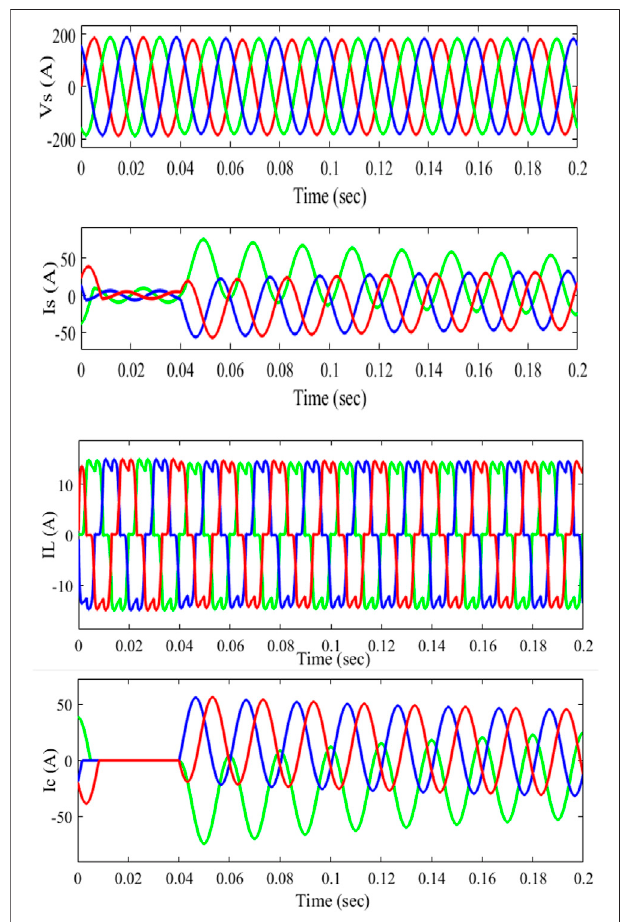
FIGURE13| AnalysisofPVirradiance,PVpower,windspeed,andwind power.